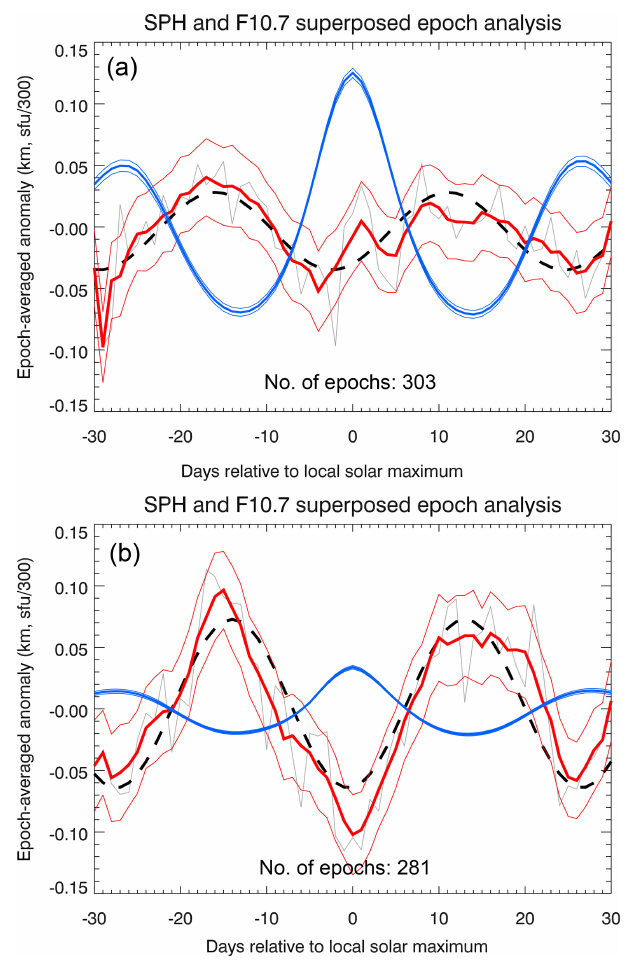
Figure 10. (a) Similar to Fig. 4 but for epochs with solar activity exceeding 130sfu. (b) Similar to Fig. 4 but for epochs with solar activity lower than